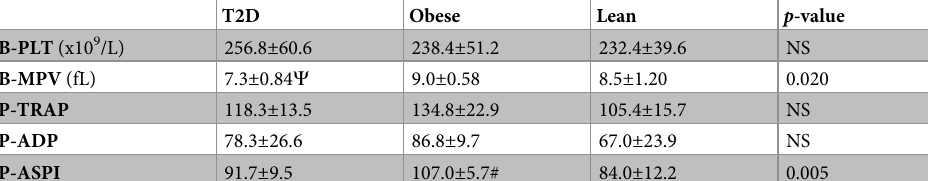
diabetic control subjects ( p = 0.019), whereas no other significant difference between the groups was observed. MPV was not correlated to BMI, plasma glucose or HbA1c. Platelet aggregation ability, measured by multiplate analyzer, was within reference values in all groups. No differences between the groups were detected; with the exception for ASPI-test where obese non-diabetic controls had an increased aggregation ability in response to arachidonic acid compared with lean control subjects ( p = 0.005). Table 3. Platelets in T2D patients compared with obese and lean control subjects.